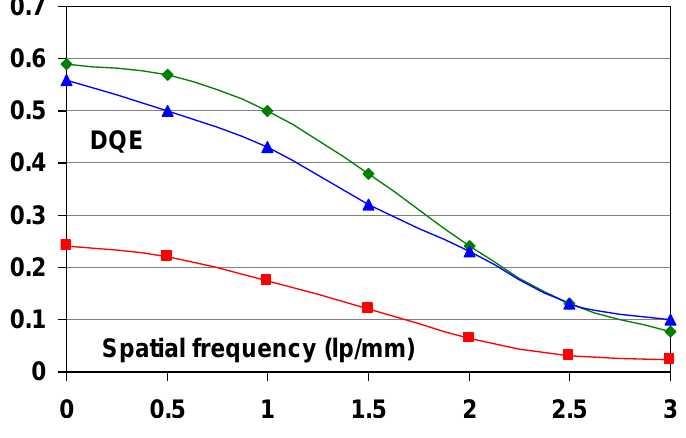
Figure 35. DQE as a function of spatial frequency for state-of-the art CR with PIP (red squares), for a 500 μ CsBr:Eu 2+ NIP, scanned in a laboratory scanner (blue triangles) and for DR with CsI:Tl (green diamonds) (data from [79]).